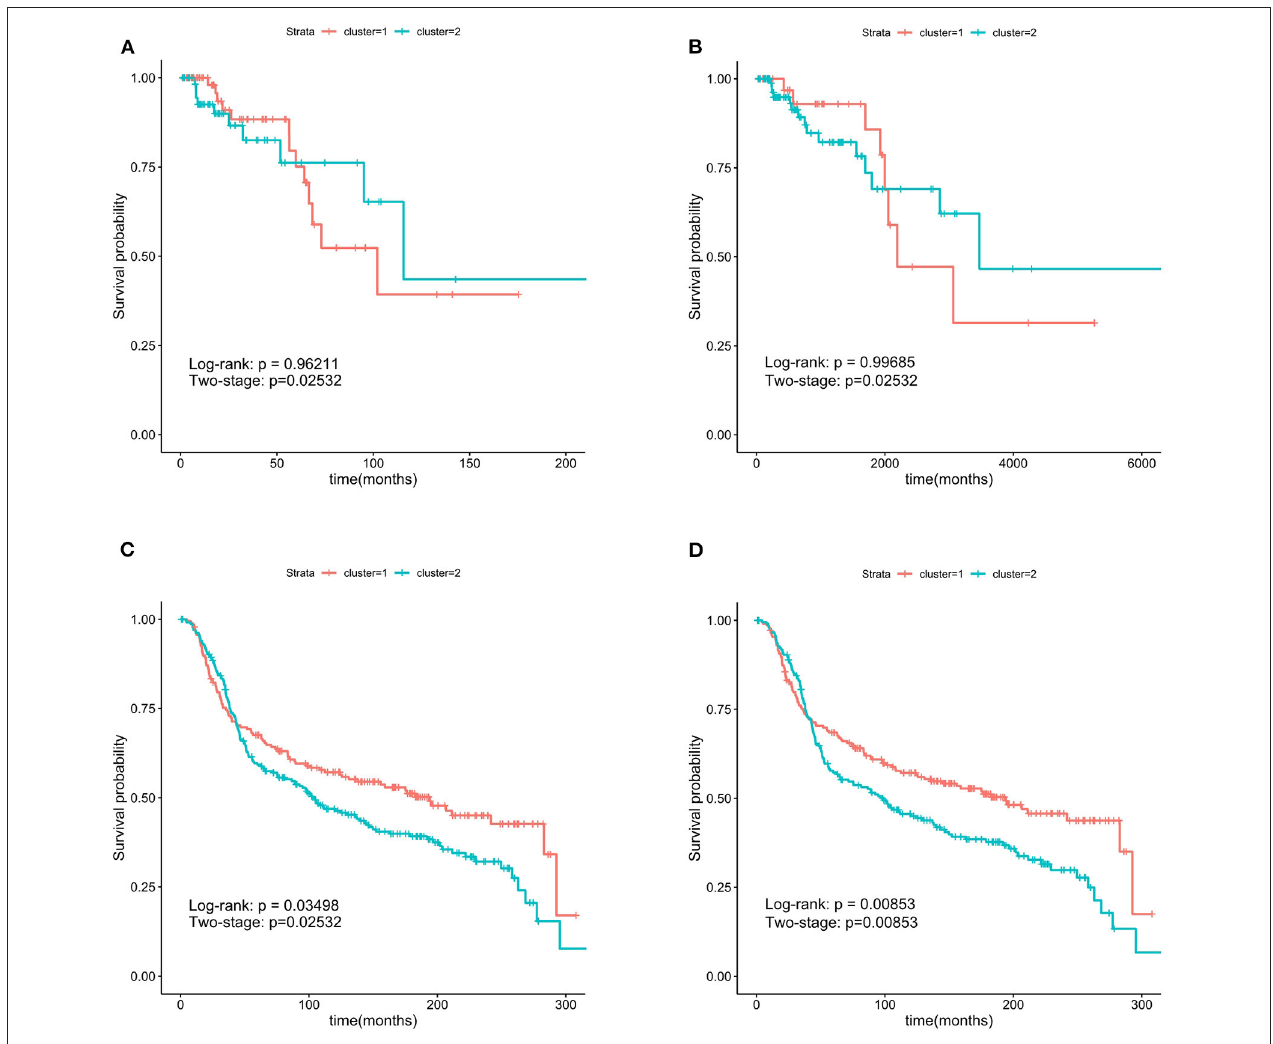
FIGURE 4 | Kaplan-Meier survival curves. The 227 important-SMGs were able to separate the patients into two groups more significantly. The P -values were smaller in METABRIC dataset. (A) Group 1 in TCGA, (B) important-SMGs in TCGA, (C) group 1 METABRIC, (D) important-SMGs in